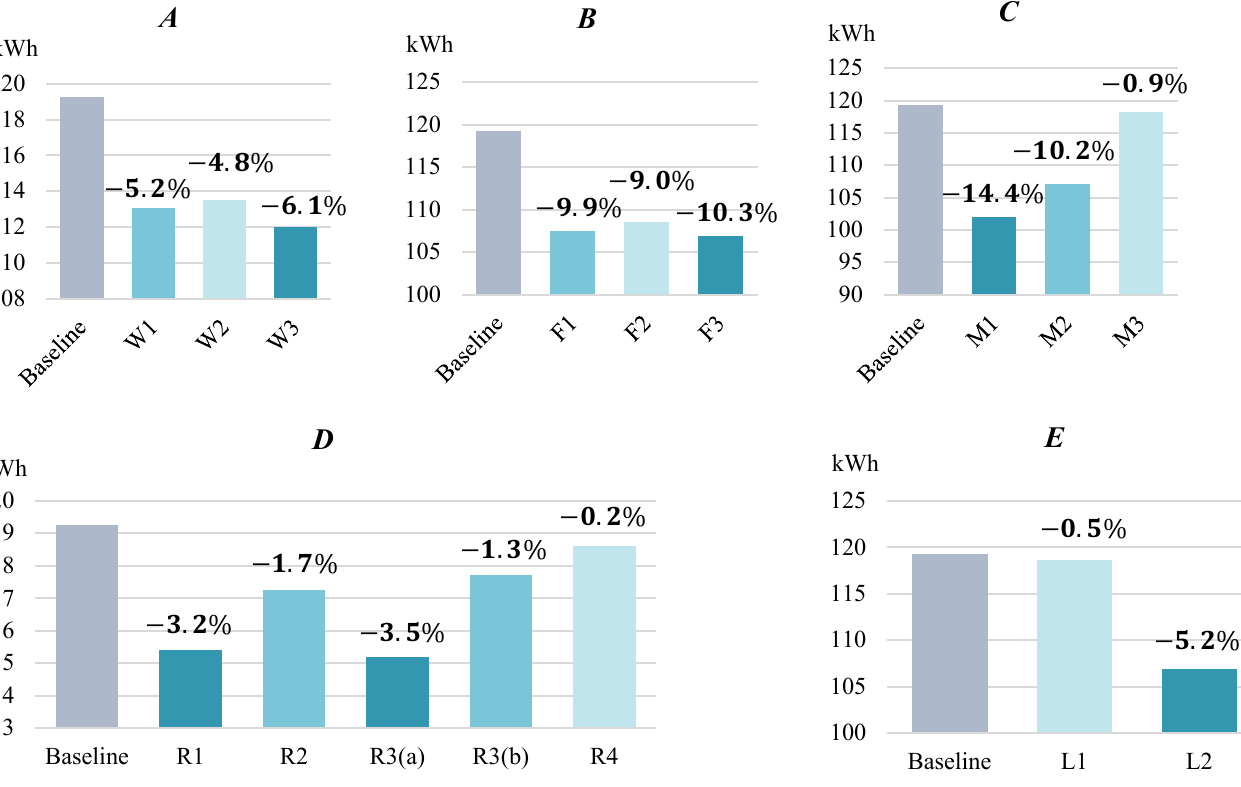
Figure 11. The single-strategy impact on the annual cooling load in kWh (referenced to the baseline model), ( A ) Walls, ( B ) Fenestration, ( C ) Microgeneration, ( D ) Roof, ( E ) Landscaping.